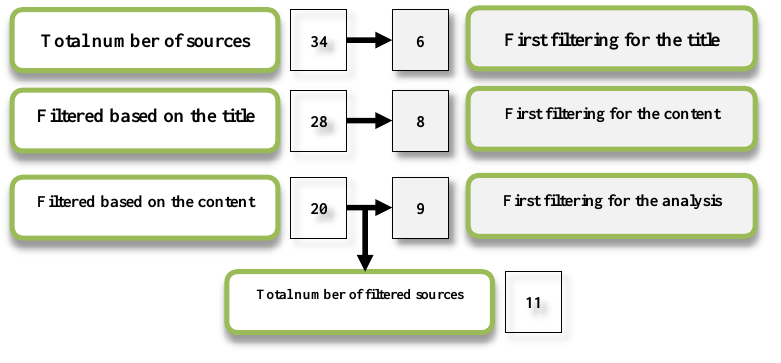
Figure 1: The process of defining the appropriate studies and articles to identify